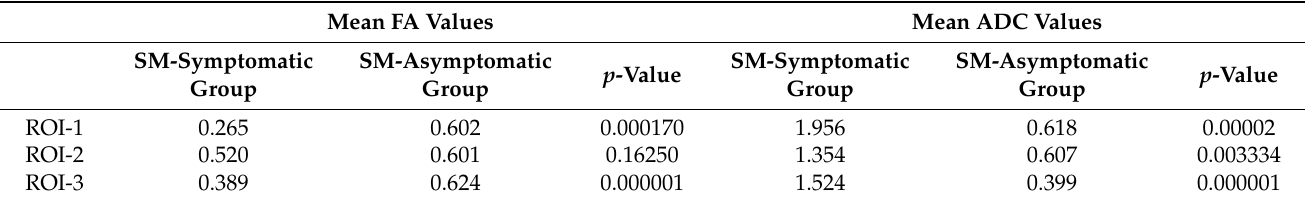
Table 5. Comparison of FA and ADC values in ROI-1, ROI-2, ROI-3 between the non-SM, SM- symptomatic and SM-asymptomatic groups.